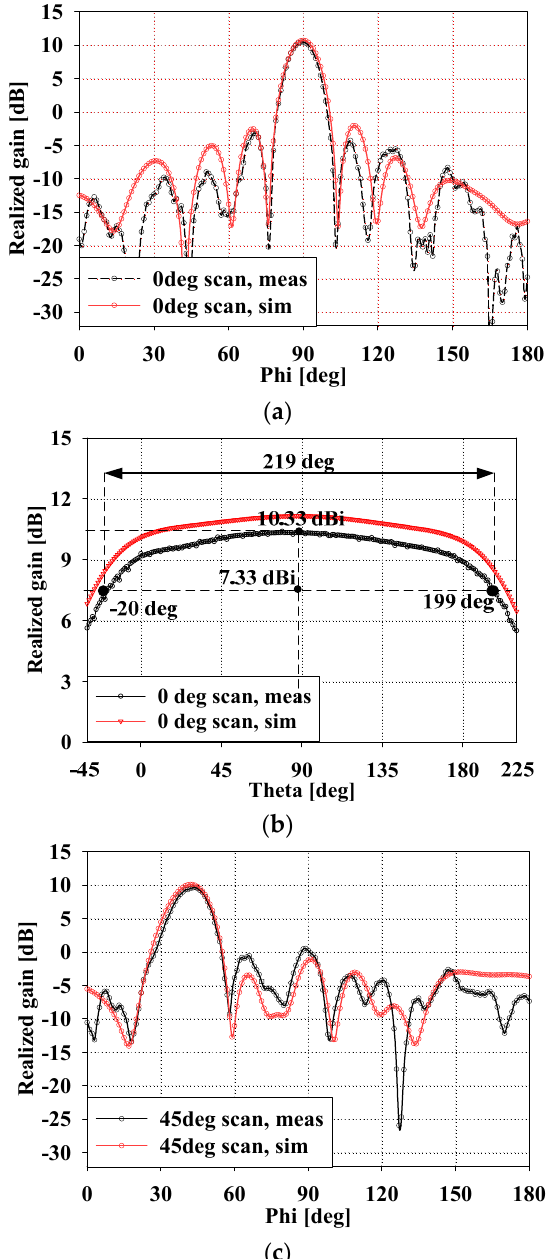
Figure 14. Measured and simulated radiation patterns of the proposed array antenna at 28 GHz: ( a ) XY plane with a 0 degree phase difference; ( b ) YZ plane with a 0 degree phase difference; ( c ) XY plane with a 120 degree phase difference.